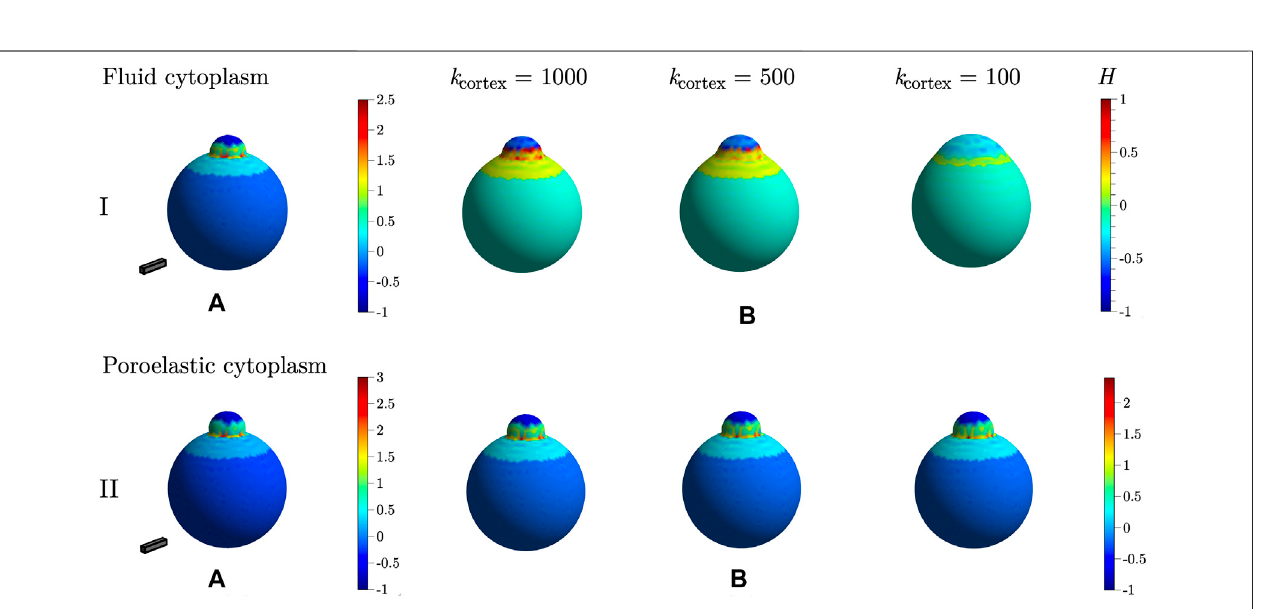
FIGURE 6 | Steady state bleb shapes and mean curvature when a bleb is initiated by (A) loss of membrane-cortex adhesion and (B) cortical ablation for different values of cortical elastic modulus k cortex . Row I shows results from the fl uid cytoplasm, and row II results are from simulations with a poroelastic cytoplasm. For the fl uid cytoplasm model, the bulk modulus of the membrane was set to k mem (cid:1) 40 pN/ μ m. For the poroelastic cytoplasm model, k mem (cid:1) 20 pN/ μ m, k cyto (cid:1) 500 Pa, and κ (cid:1) 1 · 10 – 3 μ m 3 .Otherparametersarelistedin Table1 .Thescalebarhasdimensions5 × 1 × 1 μ m.Thecolorbarindicatesthevalueofmeancurvature H overthesurface of the